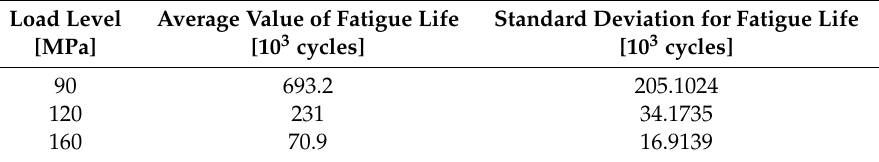
Figure 3. S - N graph for fatigue tests at three different levels of stress. Table 3. Average and standard deviation values for fatigue life. Table 3. Average and standard deviation values for fatigue life.